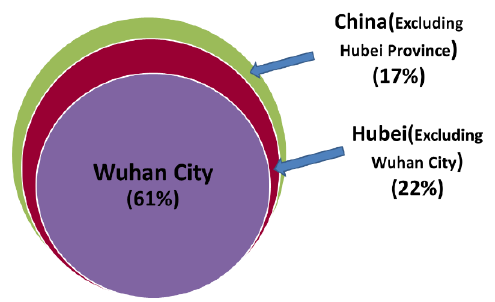
Figure 4. The distribution of confirmed local cases. Wuhan accounts for 61% of all cases in mainland China; Hubei Province accounts for 83% of all cases in mainland China, excluding Hubei Province; and cases in other provinces and cities accounted for 17% of the total in mainland China. Hubei Province, as the area most affected by the pandemic, accounts for the majority of the total cases in China, compared with the total population size of other provinces and cities.